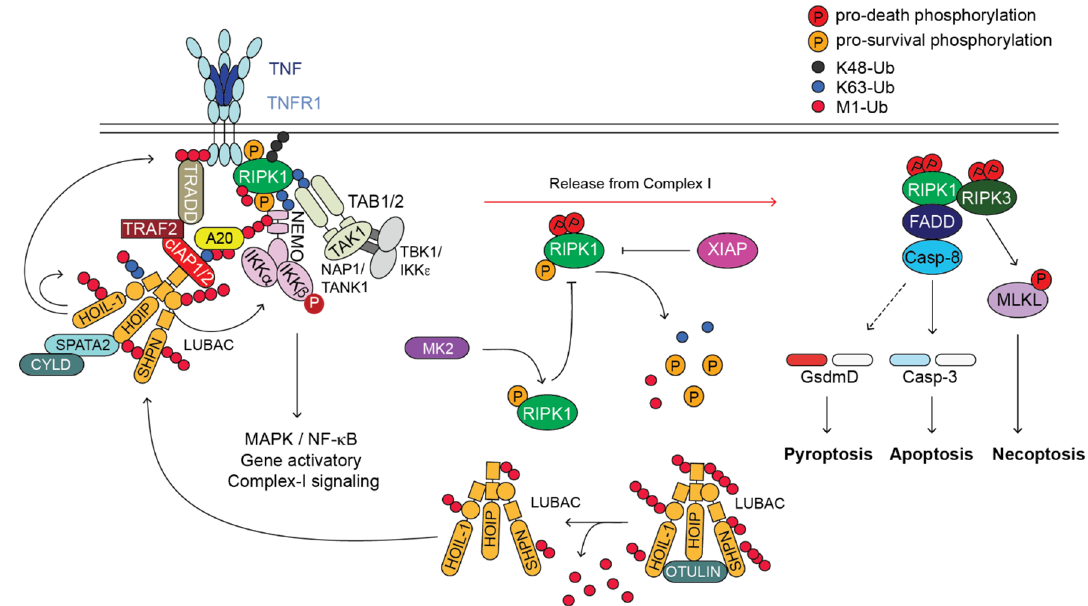
Figure 1. TNFR1-induced-signalling pathway. Cartoon depicting the TNFR1-induced-signalling pathway. Upon binding of TNF to TNFR1, a membrane-bound complex referred to as complex-I forms. This complex is characterised by the presence of adaptor proteins (e.g., TRADD, TRAF2, SPATA2, TAB1/2 and NAP1/TANK1), E3 ligases (e.g., cIAP1/2 and LUBAC), which conjugate poly-ubiquitin chains of different topology (i.e., K63, K48, K11 and M1) to different proteins of the complex, the deubiquitinases (DUBs) A20 and CYLD, and protein kinases such as RIPK1, IKK1/2, TAK1 and TBK1/IKK ε . Complex-I promotes the activation of NF- κ B and MAPKs that in turn